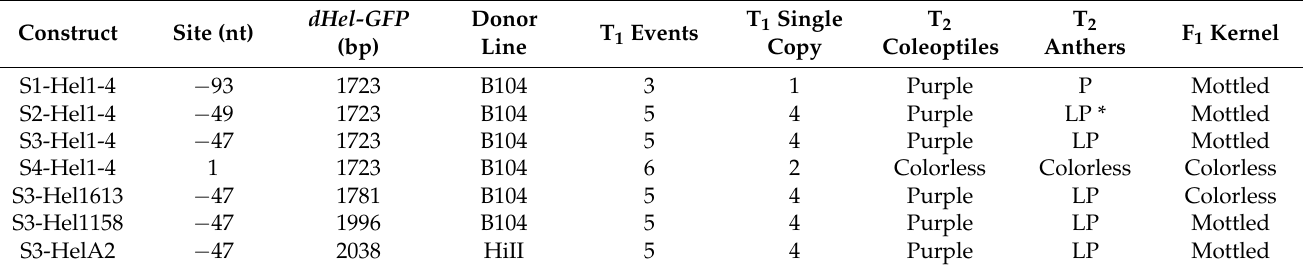
Figure 3. Kernel phenotype of test-cross ears. ( A ) Representative kernel pigmentation phenotypes of test-cross ears of the c1 tester line with primary transformants from various constructs. Anthocy- anin pigmentation is varied in test-cross ears from primary transformants harboring individual c1- dHel-GFP constructs crossed to the c1 tester. ( B ) Representative kernel phenotype of GFP fluores- cence segregation from the same test-cross ears as in ( A ) detecting under blue light illumination. 1, S3-Hel1613; 2, S3-Hel1158; 3, S3-HelA2; 4, S1-Hel1-4; 5, S2-Hel1-4; 6, S3-Hel1-4; 7, S4-Hel1-4; 8, pos- itive C1 transgenic line.